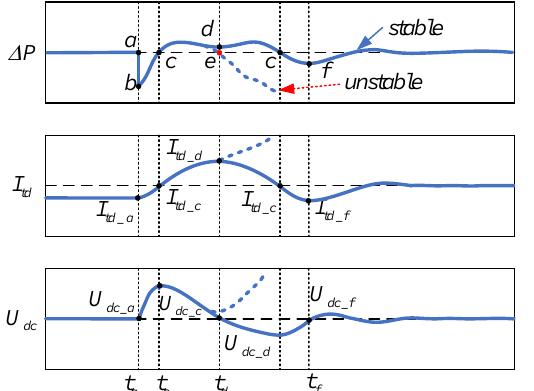
Figure 7. The theoretical oscillation waveforms of Δ P , U dc , and I td during the transient process.